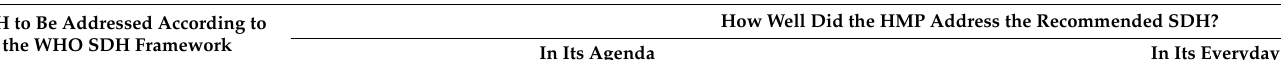
Table 2. The health ‐ mediation program’s (HMP) (in)consistencies with the World Health Organization’s Framework for action on social determinants of health (WHO SDH Framework) [18] 1 .